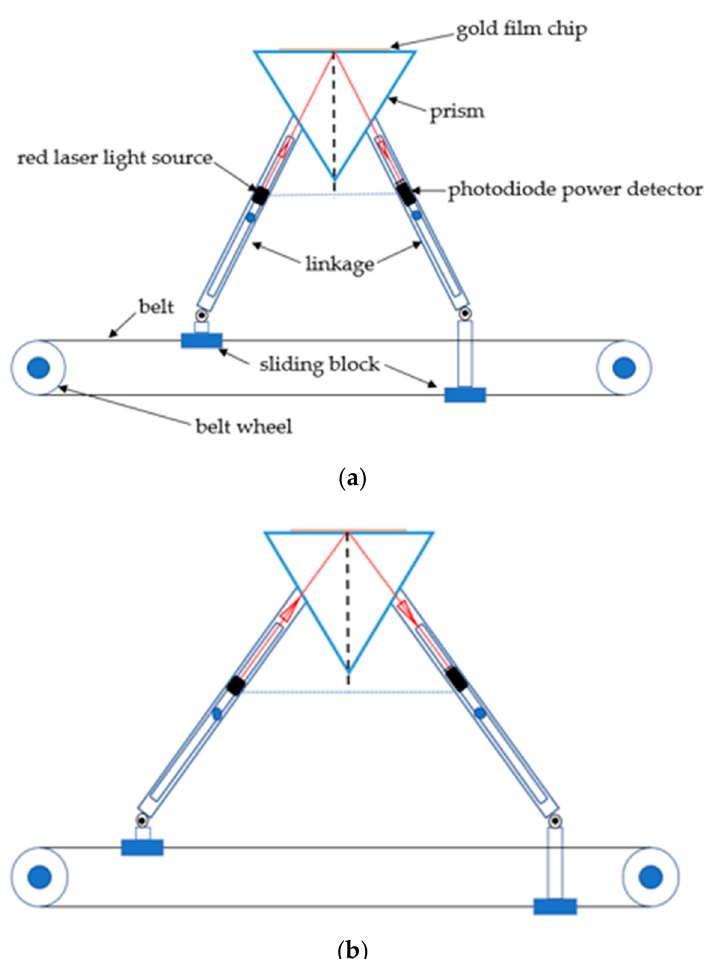
Figure 1. ( a ) Schematic of angle modulation (Position 1); ( b ) schematic of angle modulation (Position 2).